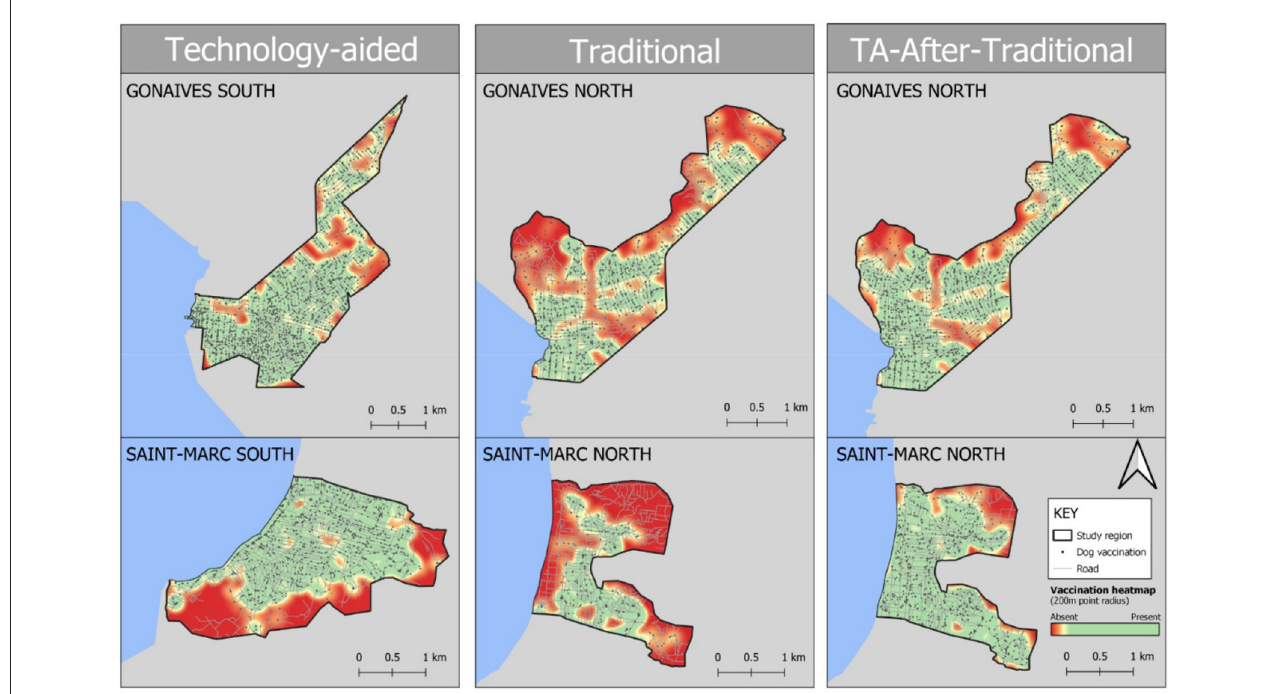
FIGURE 3 | Heatmap of vaccination distribution in study regions by vaccination methodology in Gonaives and Saint-Marc, Haiti. Individual vaccinations are indicated by gray points and roads by gray lines (Open Street Map). Heatmap is set to a radius of 200m to indicate presence or absence of vaccination effort across the region.